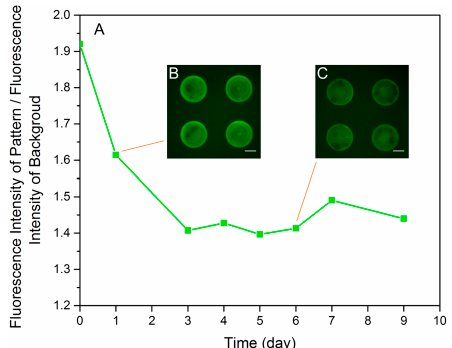
Figure 6. Lifespan of the PLL-FITC patterns in the complete culture medium. ( A ) Curve of the ratio of the fluorescence intensity of the PLL-FITC patterns to the fluorescence intensity of the background over 9 days; ( B ) fluorescence image of PLL-FITC patterns on Day 1; ( C ) fluorescence image of PLL-FITC patterns on Day 6. Images were taken with the same settings of the microscope and EMCCD camera. Scale bars are 50 μ m.